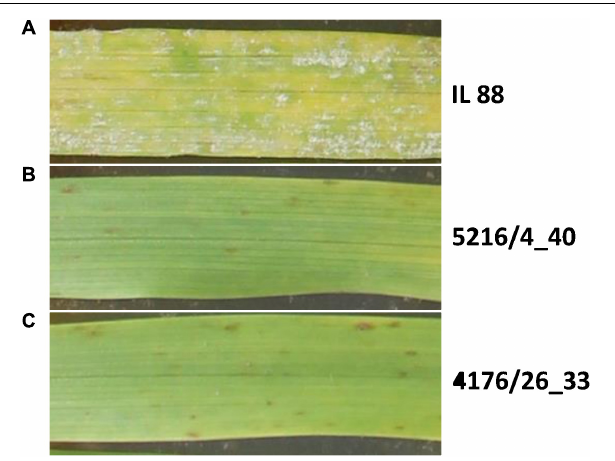
FIGURE 2 | Powdery mildew infection (isolate CH4.8) on the second leaf of seedling from the three independent Hv / Hb parental ILs, 7 days after inoculation. (A) Phenotype of the susceptible parental introgression line “IL 88” population “dIL_5216” and “dIL_4176.” (B) Phenotype of the resistant parental introgression line 5216/4_40 from population “dIL_5216.” (C) Phenotype of the resistant parental introgression line 4176/26_33 from population “dIL_4176.”